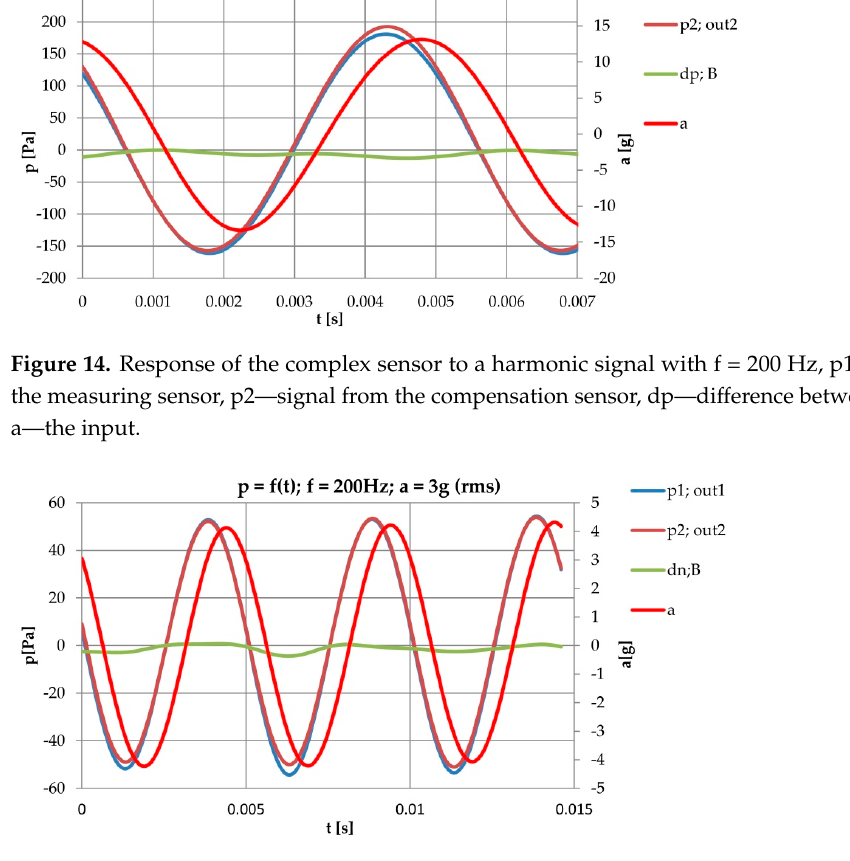
Figure 15. Response of the complex sensor to a harmonic signal with f = 200 Hz and a = 3g (Rms), p1—signal from the measuring sensor, p2—signal from the compensation sensor, dp—difference between p1-p2, and a—the input.